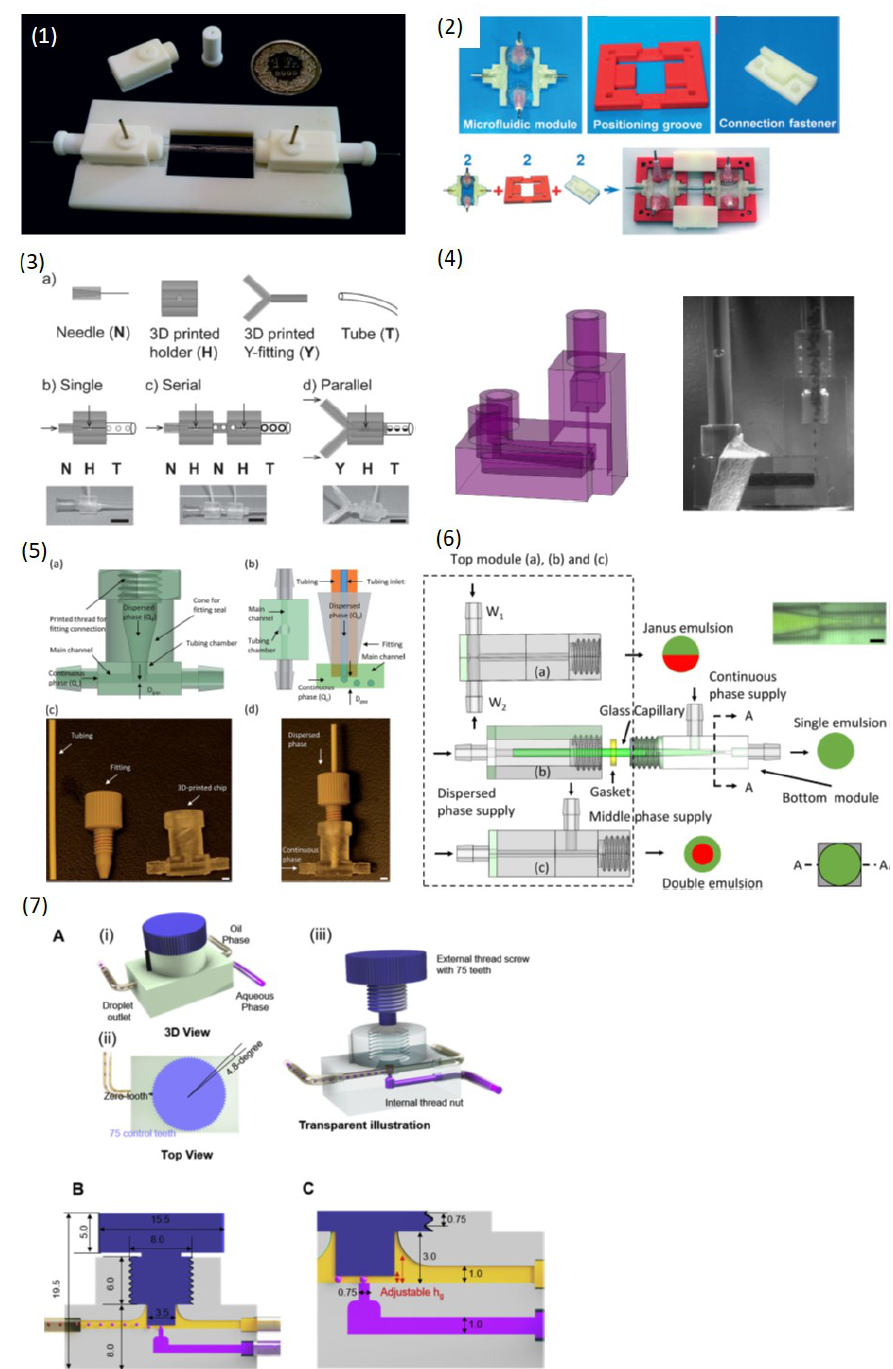
Figure 7. Hybrid droplet microfluidic devices. ( 1 ) A 3D-printed mold for flexible alignment of the glass capillary for generating double emulsions. ( 2 ) A 3D-printed groove and connection fastener for assembly of flow modules to produce multiple emulsions. ( 3 ) A 3D-printed holder and fitting for assembly of commercial needles and tubing for emulsion formation. ( 4 ) A 3D-printed chamber combined with commercial tubing to create smaller droplets. ( 5 ) 3D-printed various modules combined with a glass capillary to produce versatile emulsions. ( 6 ) A vertical T-junction structure consisting of a 3D-printed structure and commercial tubing . ( 7 ) A flexible T-junction structure formed by a 3D-printed chamber with a nut and a commercial screw. Reproduce of